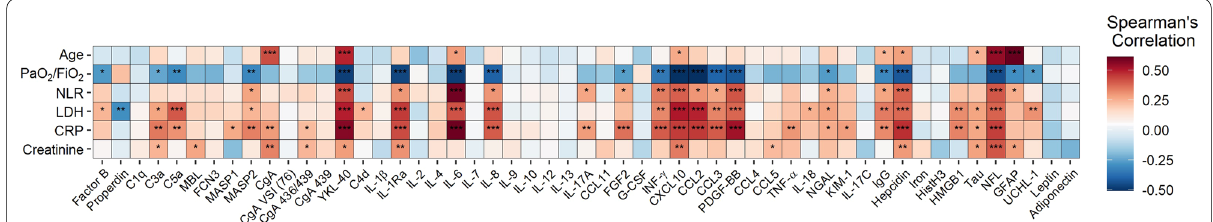
Fig. 1 Spearman’s correlations between clinical characteristics and biomarker levels. The magnitude of each correlation is denoted with a color, whereby the red color indicates a positive correlation and blue color represents a negative correlation, such that the deeper the color, the stronger is the correlation. Levels of statistical significance with false discovery rate (FDR) correction are denoted as: p < 0.05, *p < 0.01, ***p < 0.001.